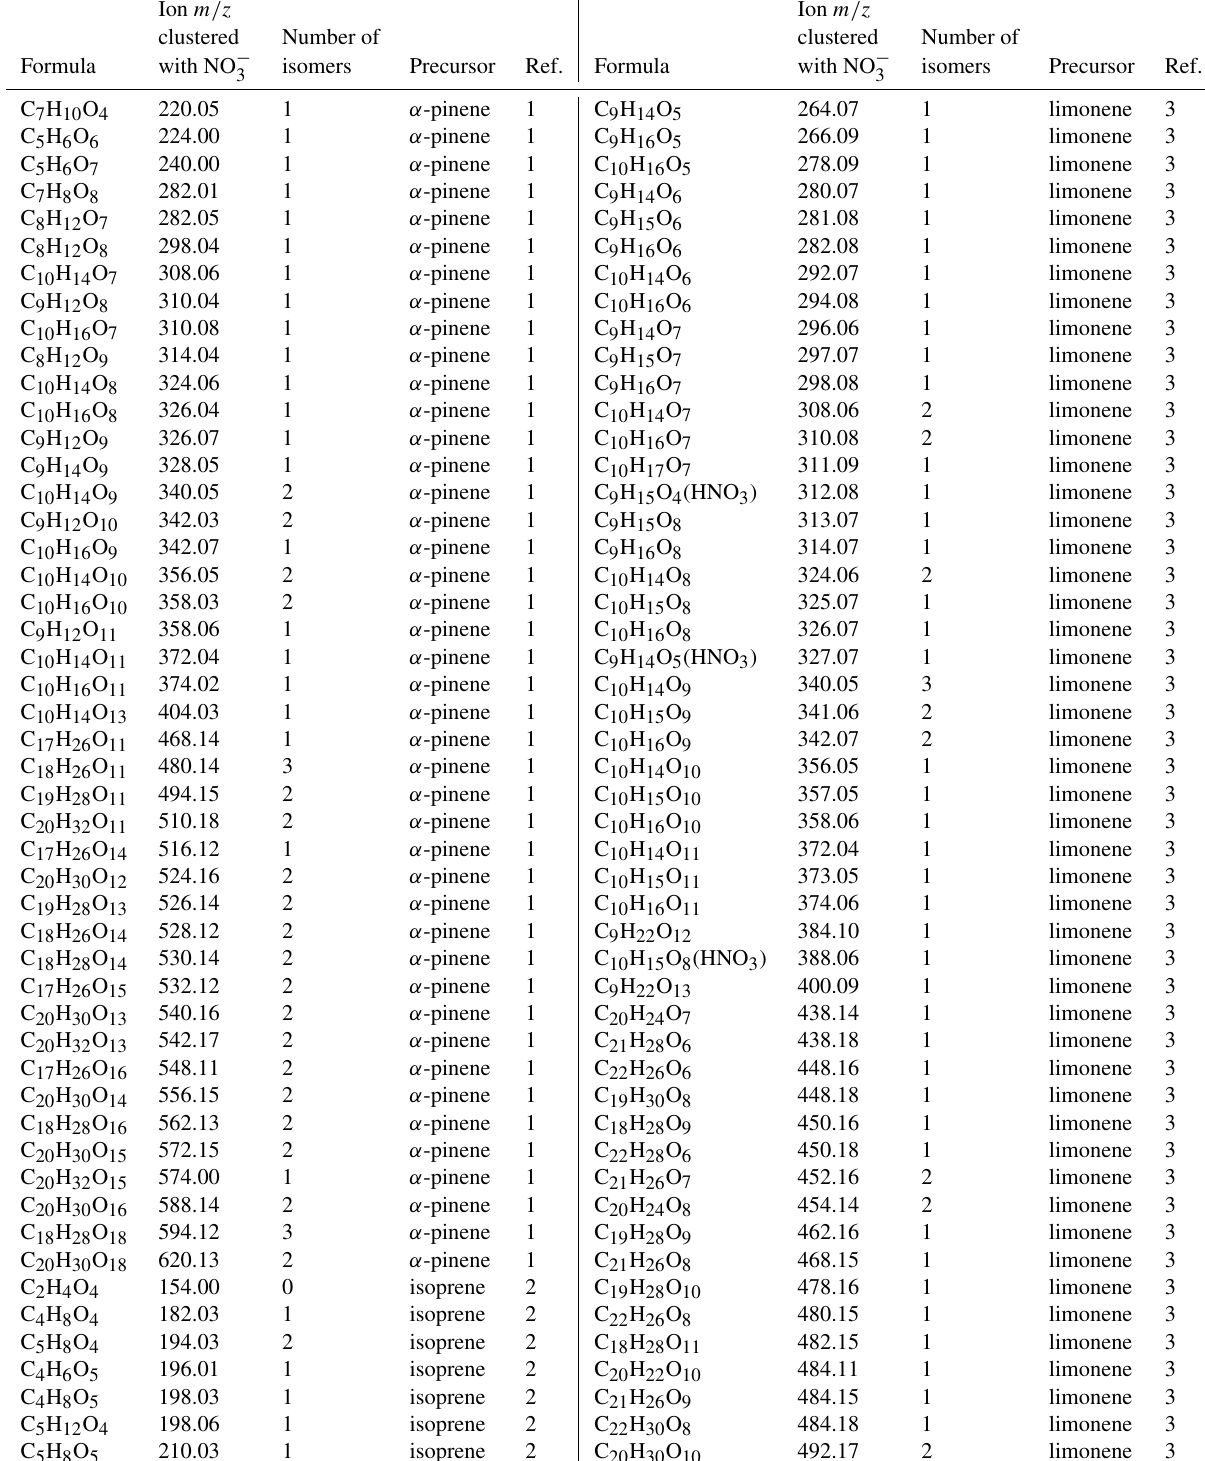
Table 1. Elemental formulas, m/z values, and the number of isomers measured with IMS–TOF. Data were extracted from O 3 and/or OH oxidation of the BVOCs (isoprene, limonene, and α -pinene) in the PAM reactor. Elemental formulas were previously identified in the literature: (1) Ehn et al. (2012), (2) Krechmer et al. (2015), (3) Jokinen et al. (2015). All compounds were detected as clusters with the nitrate ) . Some compounds previously identified in the abovementioned literature were not observed in these laboratory experiments and ion (NO − 3 are listed as having 0